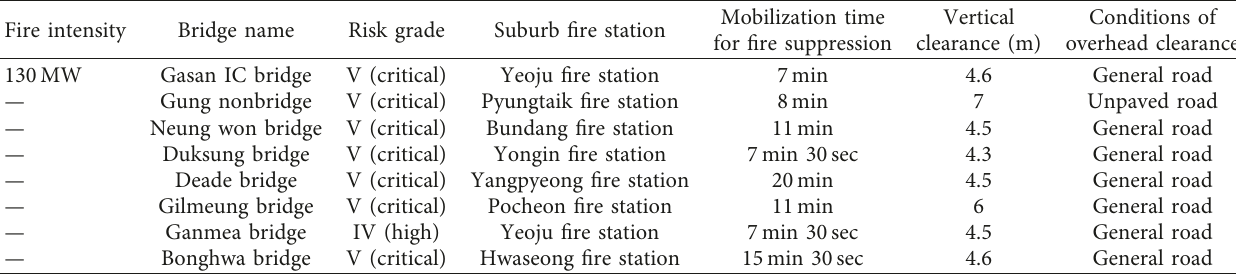
Table 11: Risk grade on concrete bridge with 130MW applied.